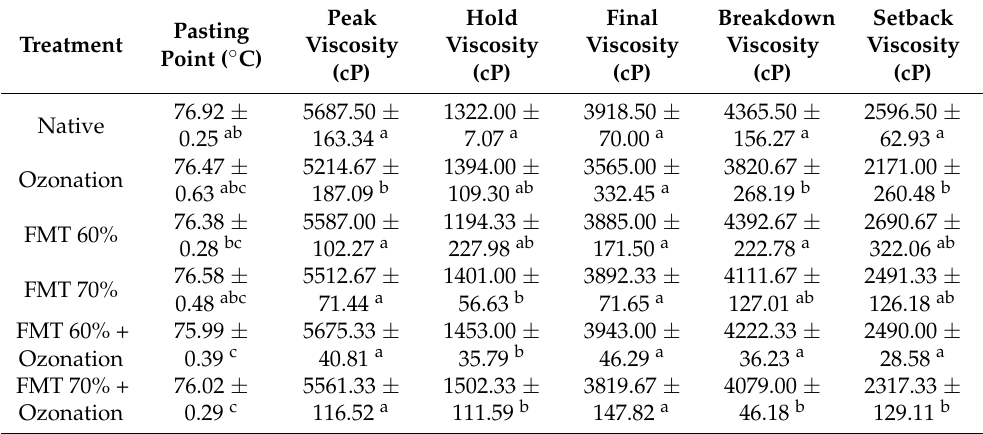
Setback Breakdown Final Hold Peak Viscosity Viscosity Viscosity Viscosity Viscosity (cP) (cP) (cP) (cP) (cP)